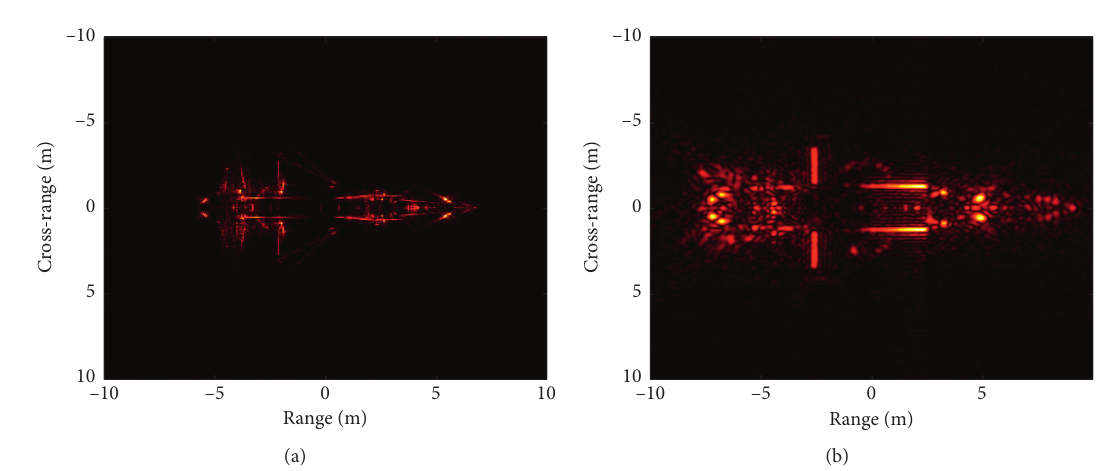
Figure 17: Final multiview ISAR image of the airplane model. (a) Simulated by large-angle and wide-bandwidth data. (b) Simulated by small-angle and narrow-bandwidth